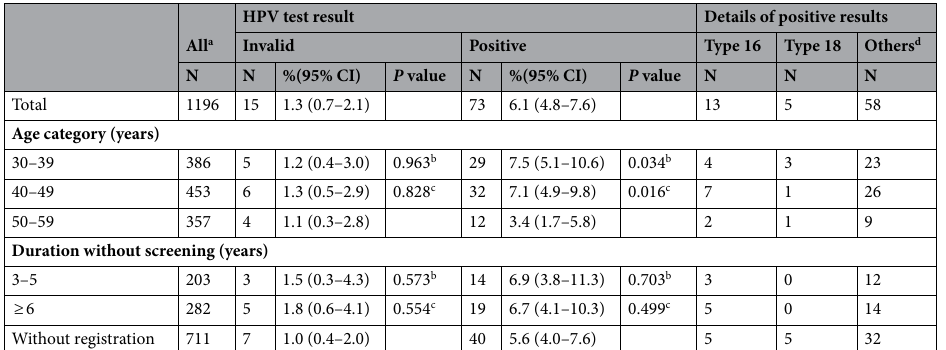
Table 3. Self-sampling human papillomavirus test results. CI confidence interval, HPV human papillomavirus, N number. a Participants who underwent the self-sampling test. b Pearson’s chi-square test. c Linear trend test.